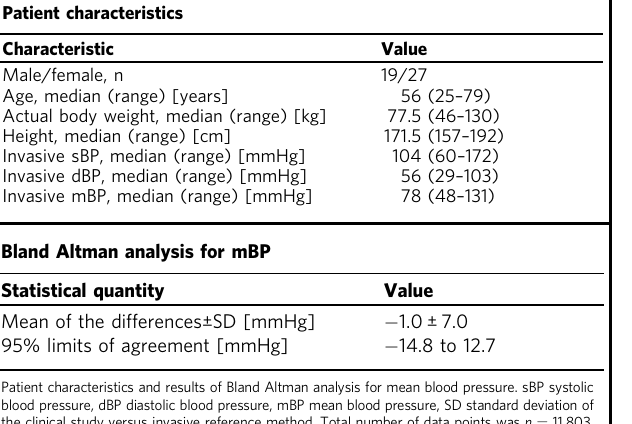
Table 2 Clinical study versus invasive reference